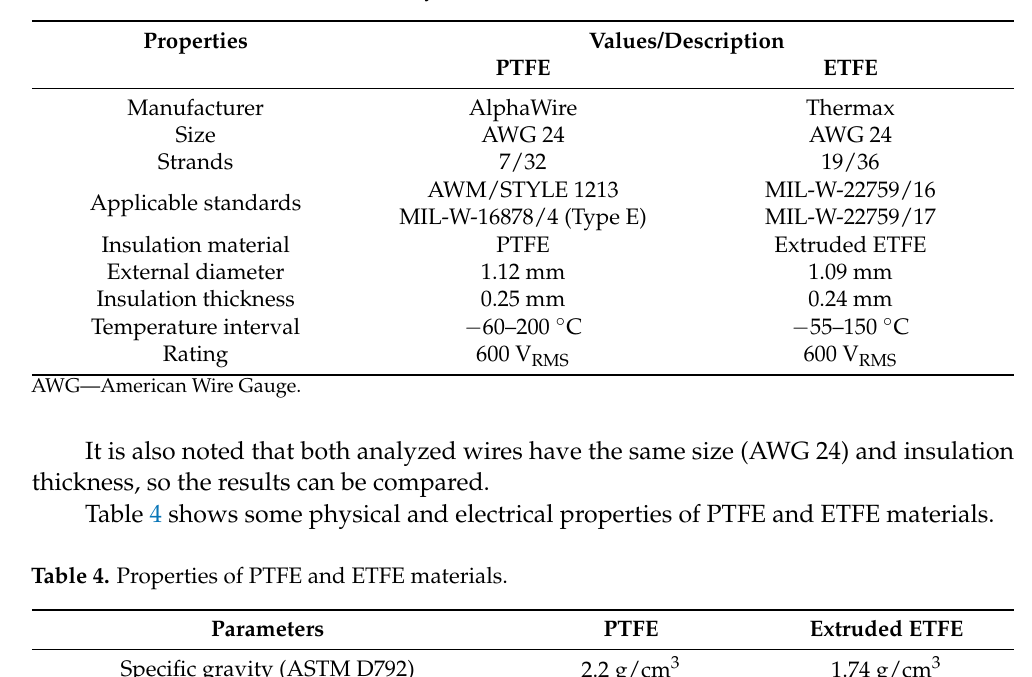
Table 3. Main characteristics of the analyzed PTFE- and ETFE-insulated